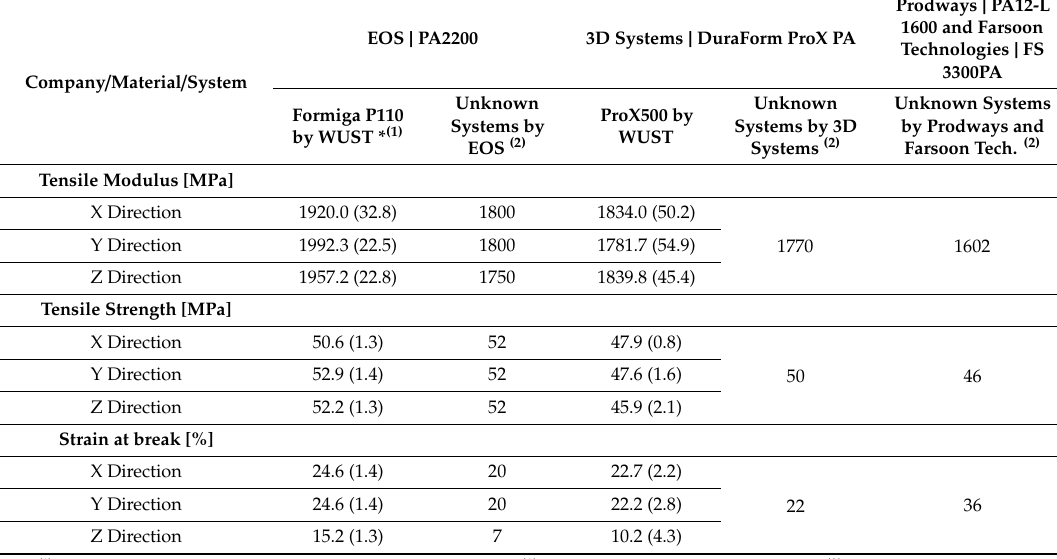
Table 5. Comparison of Mechanical Properties of PA 12 Manufactured in Di ff erent Industrial LS Systems.